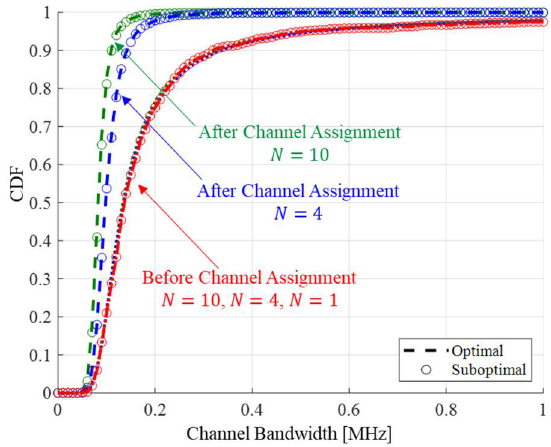
Figure 3. Cumulative distribution function (CDF) of the channel bandwidth before and after channel assignment.